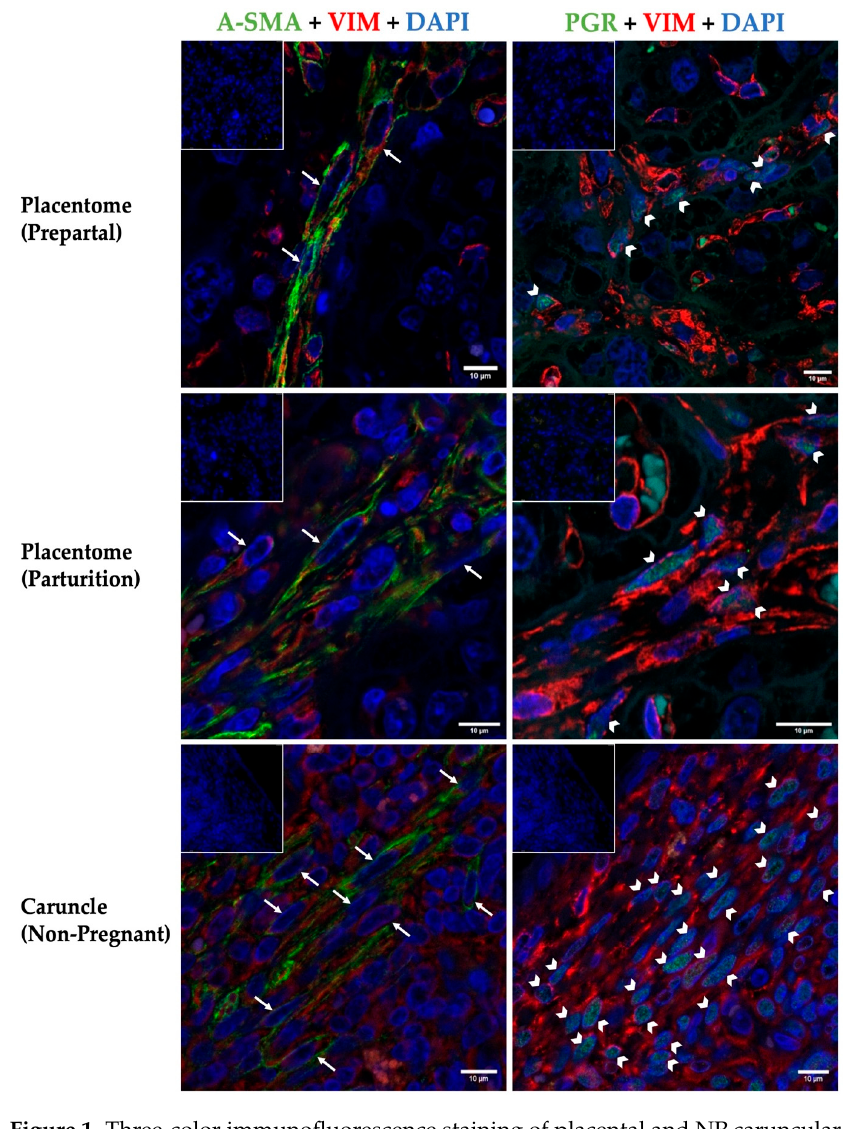
Figure 1. Three-color immunofluorescence staining of placental and NP caruncular tissue sections. Placentomes (prepartal and at parturition) from healthy cows and caruncle tissue samples from NP individuals were labeled with α -SMA (green, cytoplasm) or PGR (green, nucleus) and VIM (red). Cells which were positive for α -SMA and VIM ( α -SMA+; VIM+) were identified as myofibroblasts in the left panel (arrows). In the right panel, myofibroblasts are reflected as PGR-positive cells (arrowheads) with additional VIM signal. Nuclei were additionally stained with DAPI (blue). In merged images nuclear signals for PGR and DAPI overlap and appear in brighter white/turquoise color. Autofluorescent signal was occasionally observed in erythrocytes. For each tissue section there was no background staining, shown in the negative isotype controls